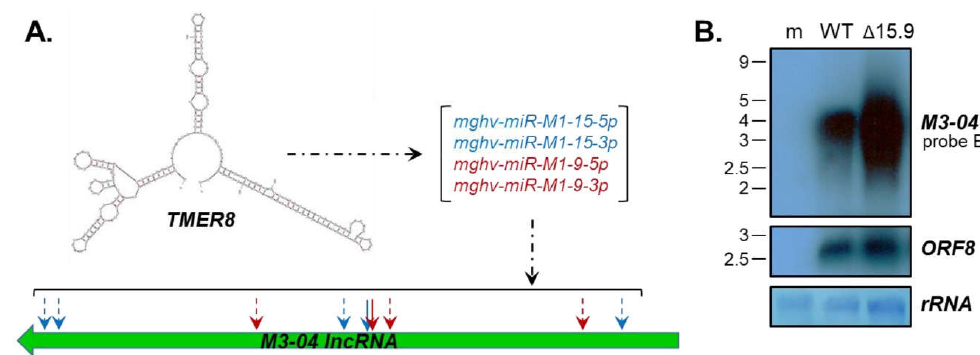
Figure 7. M3-04 is regulated by TMER8- encoded microRNAs (miRNAs). ( A ) Diagram shows in silico (m-Fold) prediction of TMER8 secondary structure, mature miRNAs encoded by TMER8 , and position of TMER8 miRNA binding within the M3-04 lncRNA. ( B ) Total RNA was harvested at 18 hours from mock-infected (m), wild-type MHV68-infected (WT), or MHV68∆15.9-infected (∆15.9) NIH 3T12 fibroblasts. Northern blots were probed with strand-specific M3/M2 locus probe B or probe to